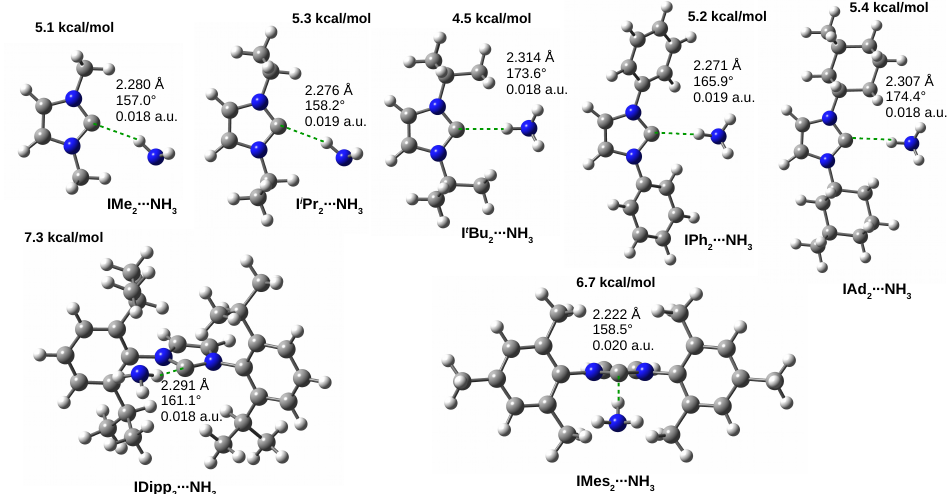
Figure 9. The IR 2 · · · NH 3 (R = Me, i Pr, t Bu, Ph, Mes, Dipp, and Ad) dimers. The values of the dissociation energy are given in bold, while the three values refer to the length of the hydrogen bond, the C-H-D angle and the value of the electron density at the bond critical point of the C · · · H-D hydrogen bond.